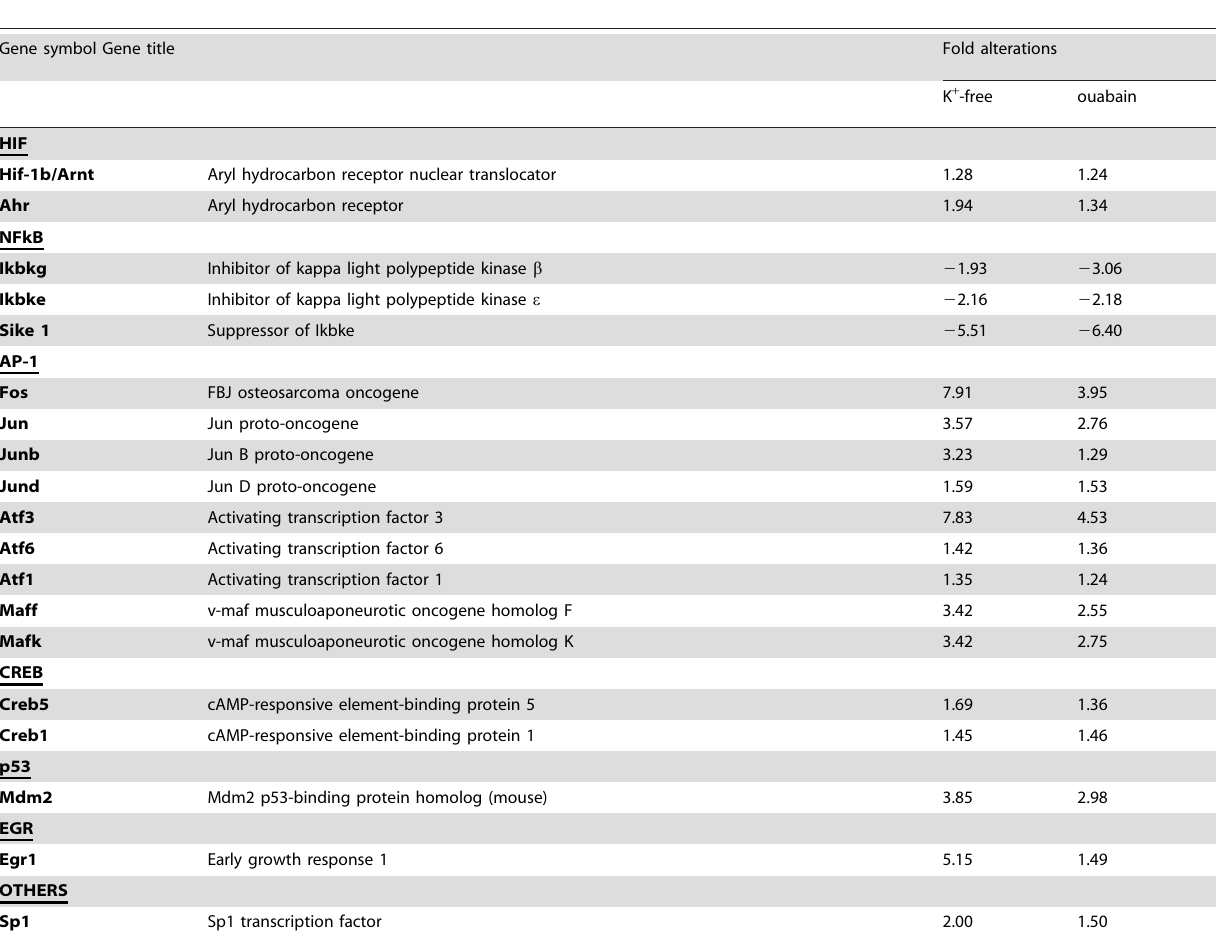
Table 3. Hypoxia-responsive transcription factors whose expression was increased in RASMC subjected to Na + ,K + -ATPase